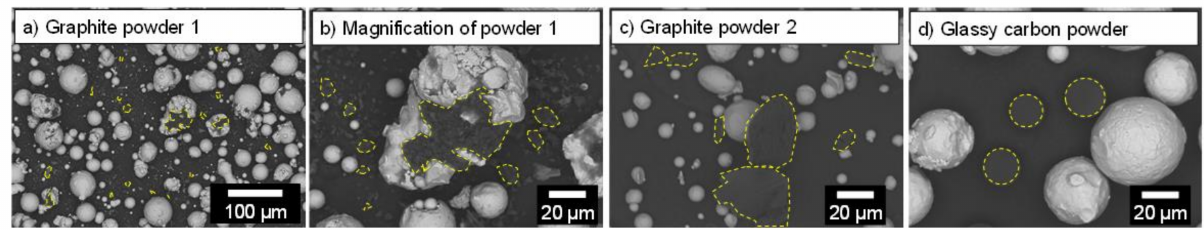
Figure 3. Powder mixtures of pre-alloyed 16MnCr5 powder with ( a ) graphite powder 1, ( b ) magnification of graphite powder 1, ( c ) graphite powder 2, ( d ) glassy